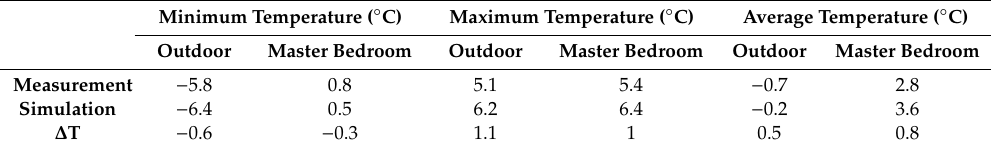
Table 4. Comparison of measured and simulated temperature data.